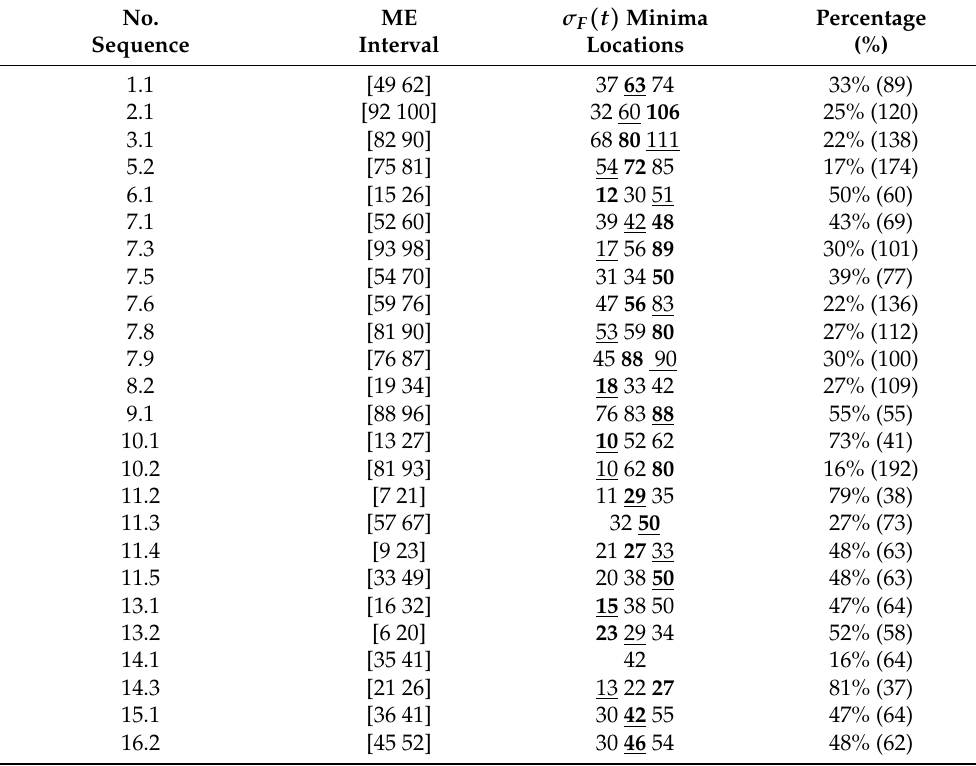
Table 2. Frozen frames detection results achieved on the MEVIEW dataset [38]. For each video subsequence (first column), the frame interval including the ME is provided (second column), along with the location of the first three absolute minima, if any, of σ F ( t ) (third column): the closest location to the ME interval is in bold, while the location where the absolute minimum is realized has been underlined. The last column contains the percentage of frames that need to be analyzed with a more precise spotting algorithm: for each minimum, 10 frames have been considered (5 before and 5 after). The length of the reference video-cut is indicated in the